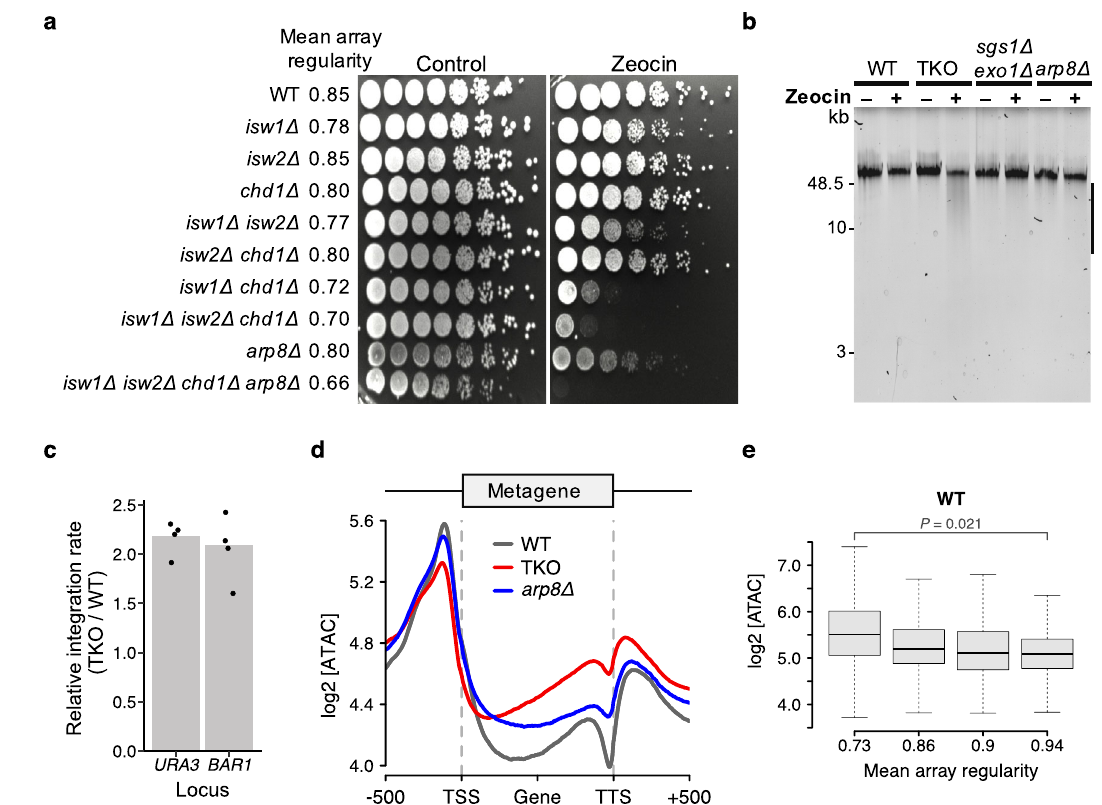
Fig. 7 ISWI and Chd1 remodelers protect the genome from genotoxic stress. a Growth assay for indicated yeast strains on YPAD with and without Zeocin (100 µ g/ml). b Zeocin-induced fragmentation of genomic DNA (bar) for the indicated strains. Cells were treated with deionized water ( − ) or Zeocin ( + ; 1 mg/ml) for 10 min. See Supplementary Fig. 7b for a biological replicate. c The TKO strain endures higher levels of ectopic recombination than the WT. Homologous recombination tested at two genomic loci ( URA3 , BAR1 ). Dots represent individual replicates from four independent experiments. Source data are provided as a Source Data fi le. d Metagene plot of ATAC-seq signals for WT, TKO, and arp8 Δ cells from four independent replicates. e The number of ATAC-seq insertions into gene bodies anti-correlates with array regularity in WT cells. Genes were fi ltered for an absolute nucleosome occupancy between 0.78 and 0.88 66 , sorted by array regularity measured in WT cells and then divided into four quartiles. P -value ( P ) represent statistical analyses performed with two-tailed paired Welch ’ s t -test on the mean values of two replicates. Central line in box plot indicates the median, the box shows the interquartile range, and whiskers indicate data points within 1.5 times of the interquartile